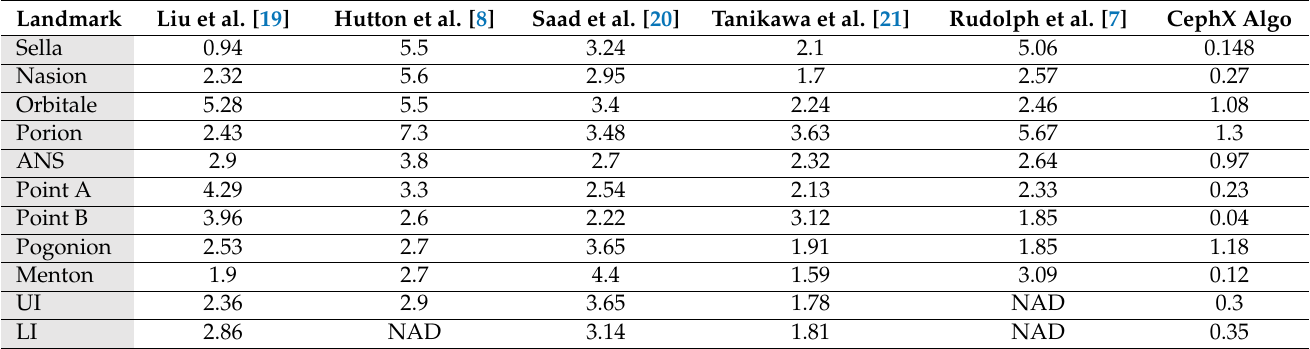
Table 3. Mean measurement error (mm) of human vs. AI from early